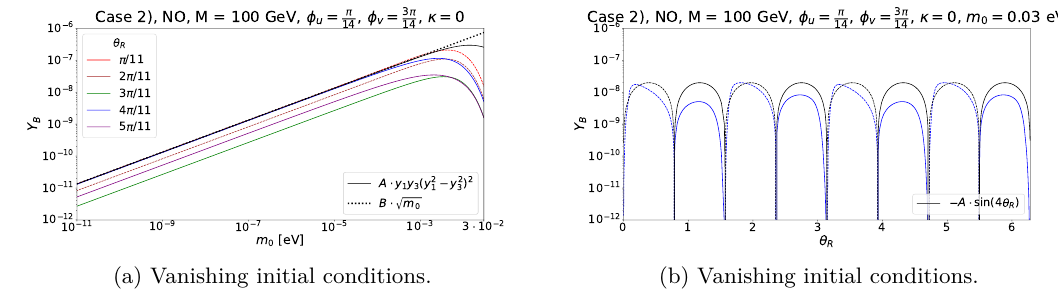
Figure 17 . Case 2) Results for Y B in the absence of splittings, κ = 0 (and λ = 0 ). We set the Majorana mass M to M = 100 GeV and fix the group theory parameters n , s and t to n = 14 , and φ = 3 π . Light neutrino masses follow NO. The left plot s = 1 and t = 1 such that φ u = π v 14 14 displays Y as function of the lightest neutrino mass m for different values of θ . In addition, B 0 R we compare, for θ = π , the numerical results (red curve) with the following two analytical R 11 √ expressions: A · y ( y 2 ) 2 with A ≈ − 6 . 14 · 10 31 (continuous black line) and B · − y 2 m 0 with 1 y 3 1 3 B ≈ − 4 . 26 · 10 − 6 eV − 1 / 2 (dotted black line). The first expression reflects the dependence of the CP-violating combination C on the couplings y , compare eq. (6.28), while the second one DEG ,α f gives the overall dependence of the BAU on m . The right plot shows Y as function of the angle θ . 0 B R We compare the numerical result (blue curve) to the analytical expectation from the CP-violating combination C which is proportional to sin 4 θ (black curve). The coefficient A has been DEG ,α R chosen to be Max( | Y ). Both negative (dashed lines) as well as positive (continuous lines) values of B | the BAU are